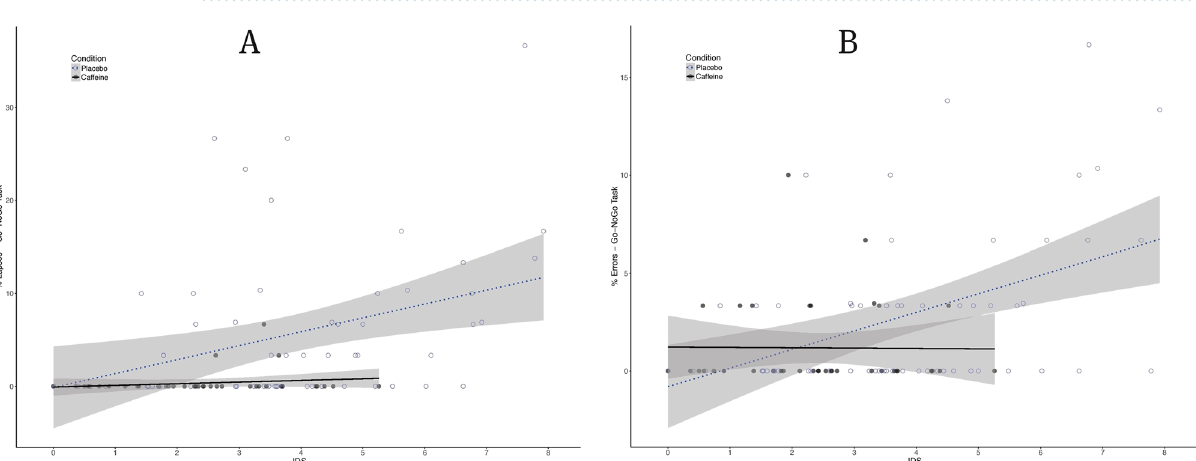
Figure 2. Performance on the Go-NoGo task (GNG) as a function of drowsiness (JDS scores averaged over 5 min prior to the task) for the caffeine (black filled circle, n = 4) and placebo (black open circle, n = 6) groups across our 50-h TSD protocol. ( A ) Percentage of Response Lapses (omission errors). ( B ) Percentage of commission errors (false alarms). Shaded areas represent 95% CIs over regression